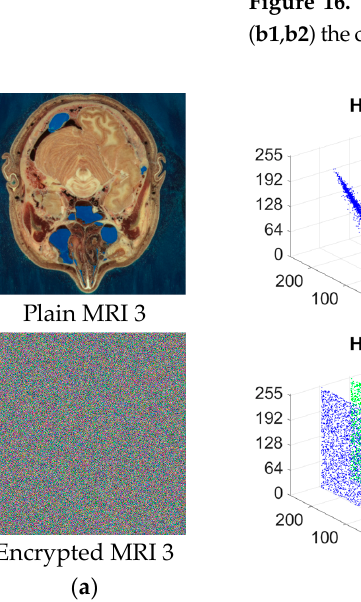
× × with their encrypted versions and with their encrypted versions and